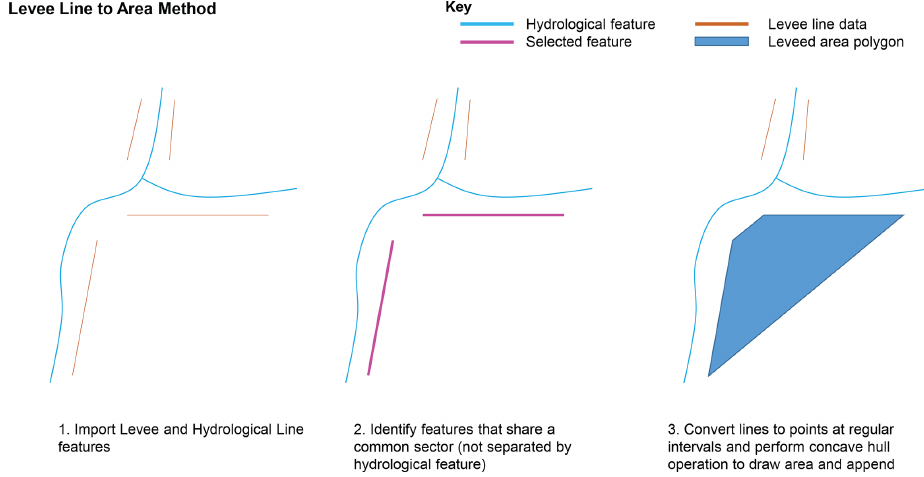
Figure 1. Extraction of leveed areas from levee line information (visual representation of process outline in Fig. S3).